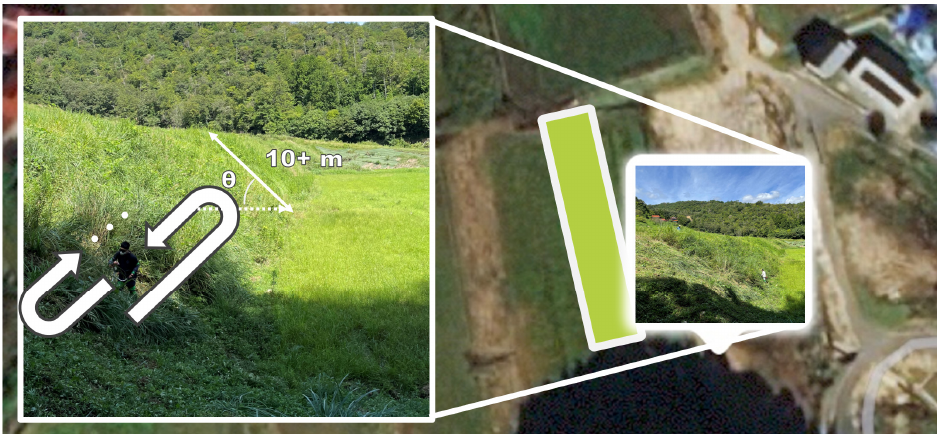
Figure 6. An Example of the Mowing Motion Decomposition.